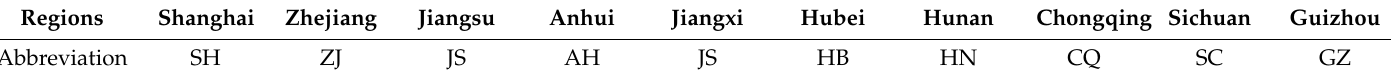
Table A1. Abbreviations in the selected region.